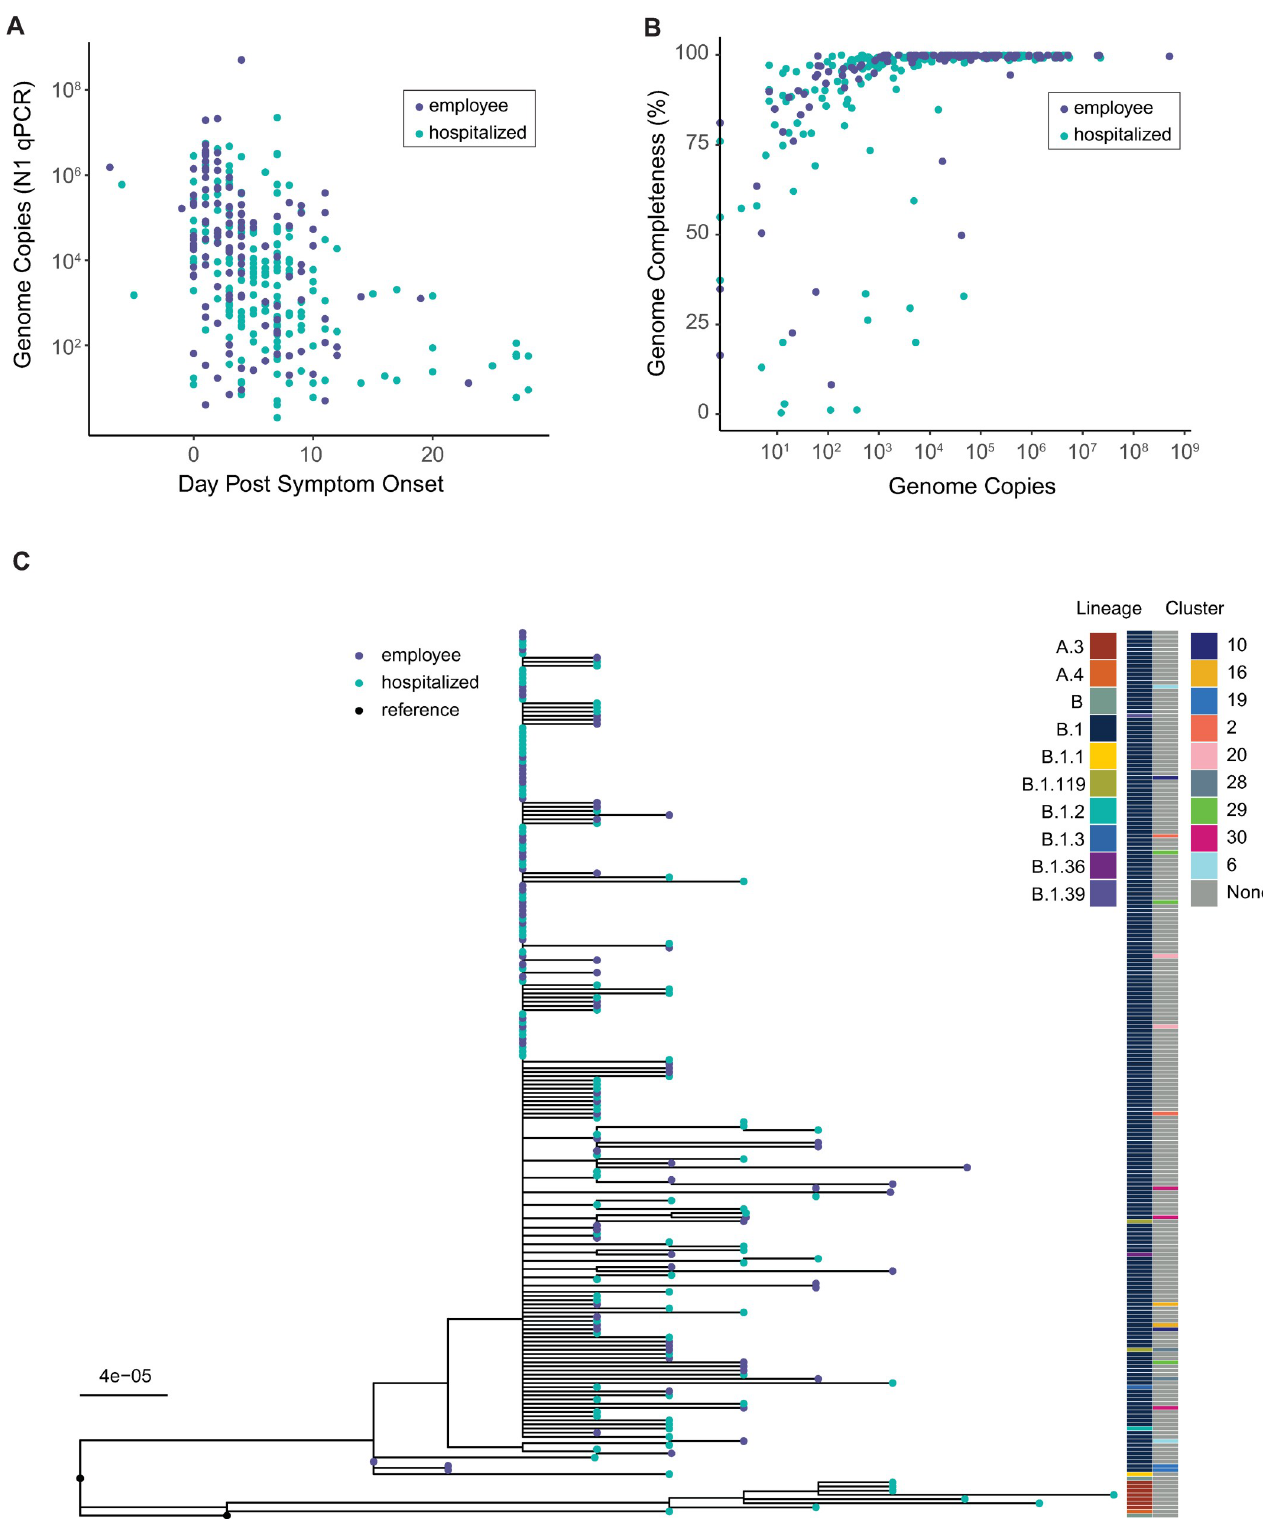
Fig 1. Viral shedding and overview of genome sequencing data. (A) Viral load by day of infection in hospitalized patients (teal) and employees (violet). Viral load, measured by qPCR of the N gene in units of genome copies per microliter of extracted RNA, is on the y-axis and day post symptom onset is on the